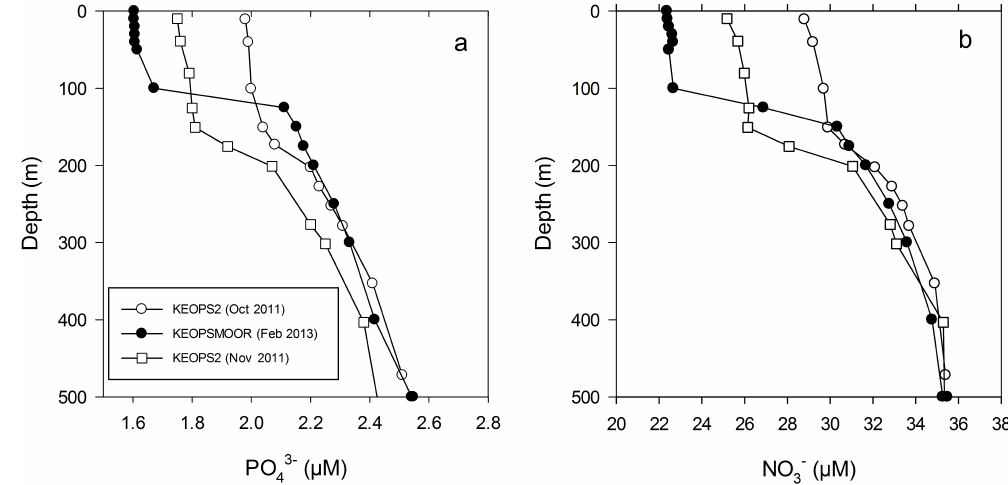
Figure 8. Temporal variability of the vertical profiles of concentrations of NO −